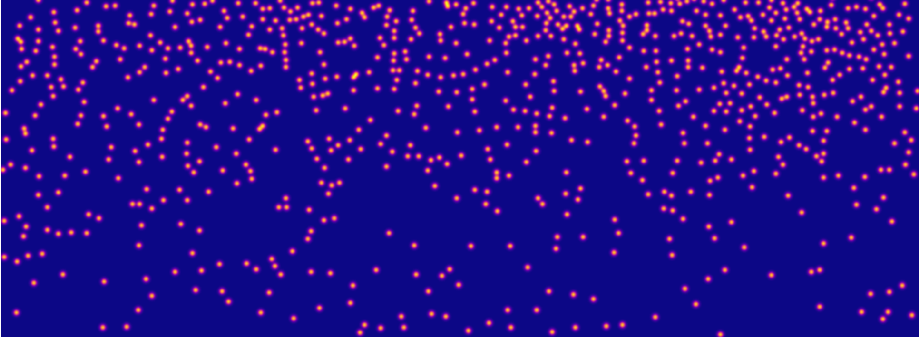
Figure 2. Typical example of a ground-truth map as cumulative Gaussian distributions, one per head. The score associated to each pixel of the ground-truth map is the sum of the contributions of each Gaussian at the given location. In the image, scores span from blue (low) to yellow